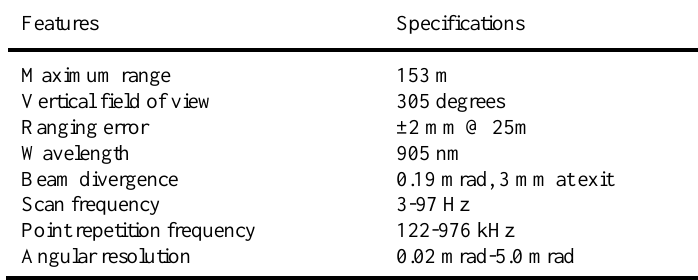
Table 2. Specifications of the laser scanner (FARO Focus3D 120 a